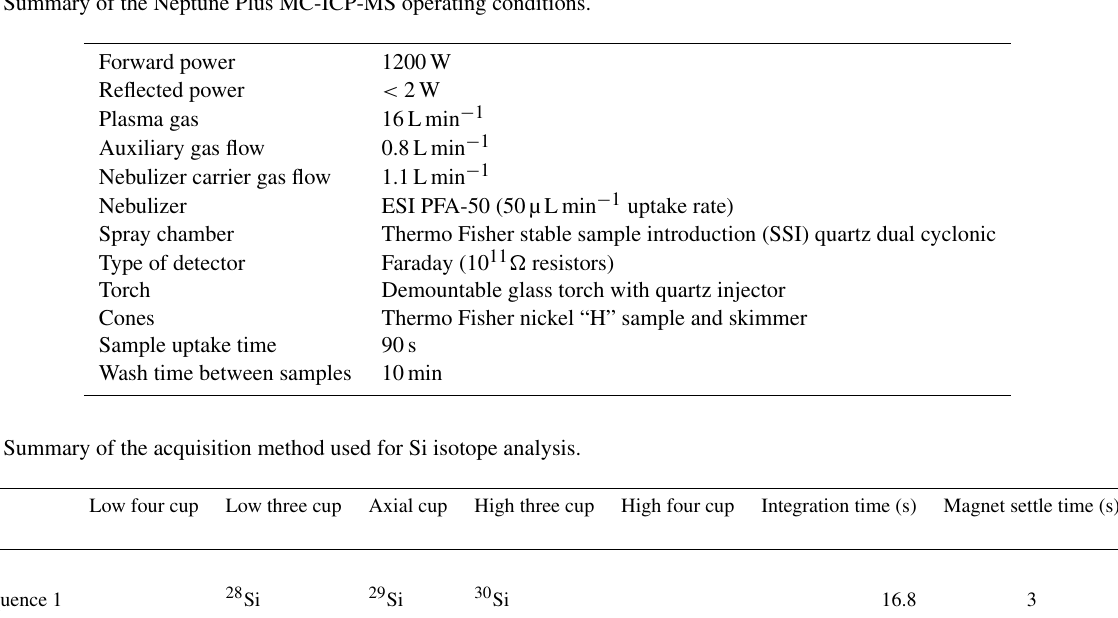
Table 1. Summary of the Neptune Plus MC-ICP-MS operating conditions.